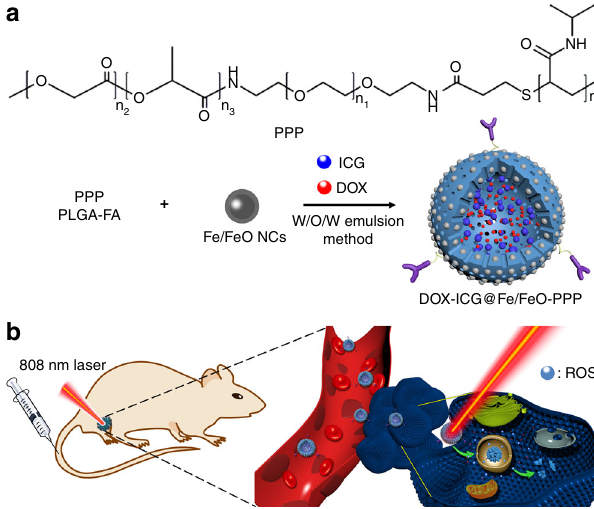
Fig. 1 Synthesis and biomedical application of DOX – ICG@Fe/FeO – PPP nanocapsules. a Fabrication of DOX – ICG@Fe/FeO – PPP nanocapsules. b Schematic representation of nanocapsules for imaging-guided stimuli- responsive chemo/photo- and chemodynamic therapy. PPP Poly (lactic-co- glycolic) acid – polyethylene glycol – poly ( N -isopropyl